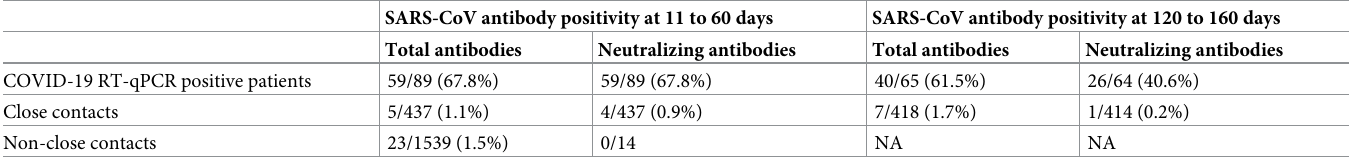
Table 2. The presence of SARS-CoV-2 specific total antibodies and neutralizing antibodies in COVID-19 patients, their close contacts and non-close contacts in the Colombo Municipality region. SARS-CoV antibody positivity at 11 to 60 days SARS-CoV antibody positivity at 120 to 160